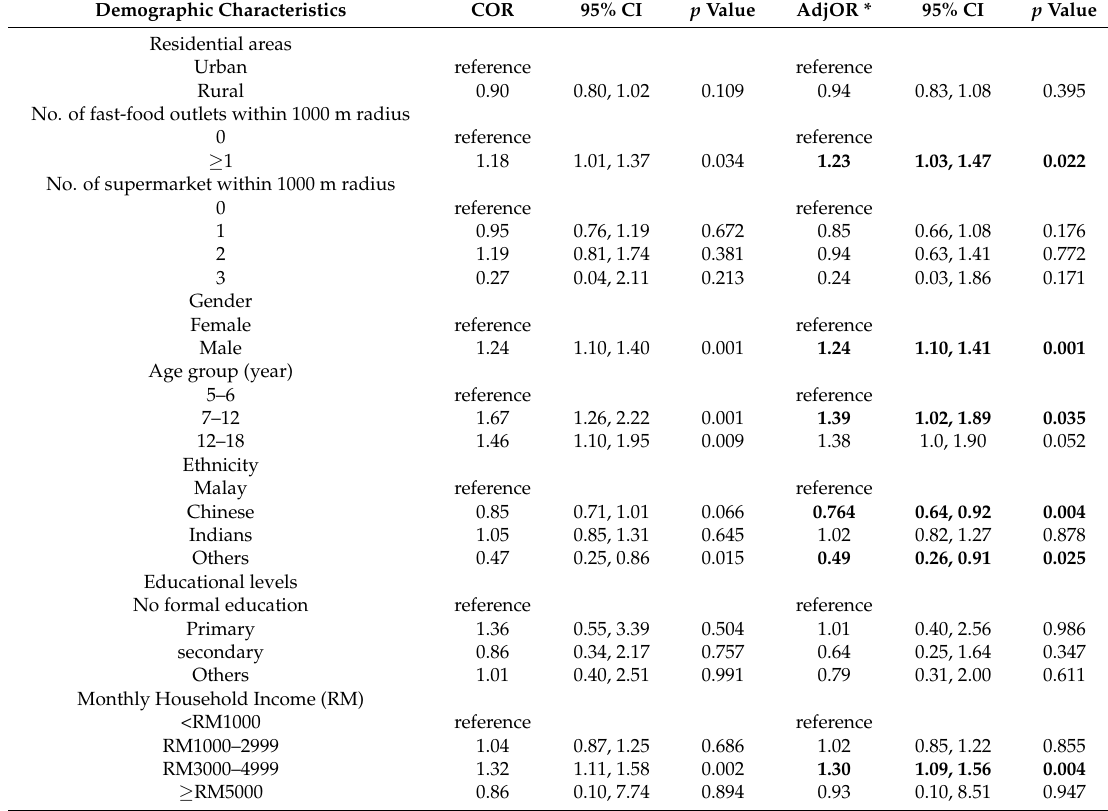
Table 2. Multivariable logistic regression analysis of association between overweight children and availability of fast-food outlets in Peninsular Malaysia ( n =